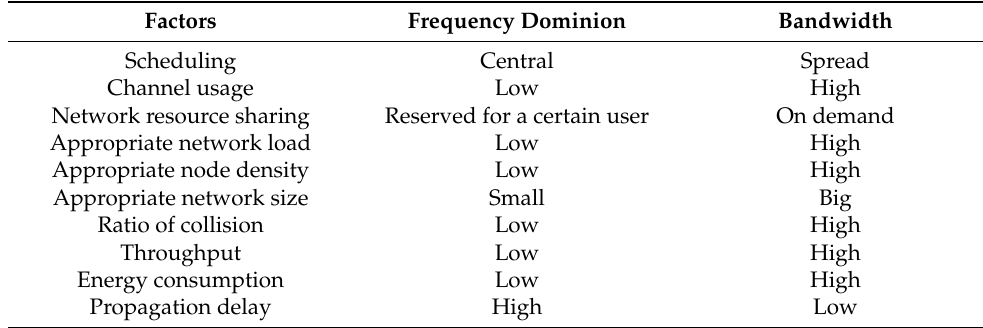
Table 6. The evaluation among frequency dominion and bandwidth MAC